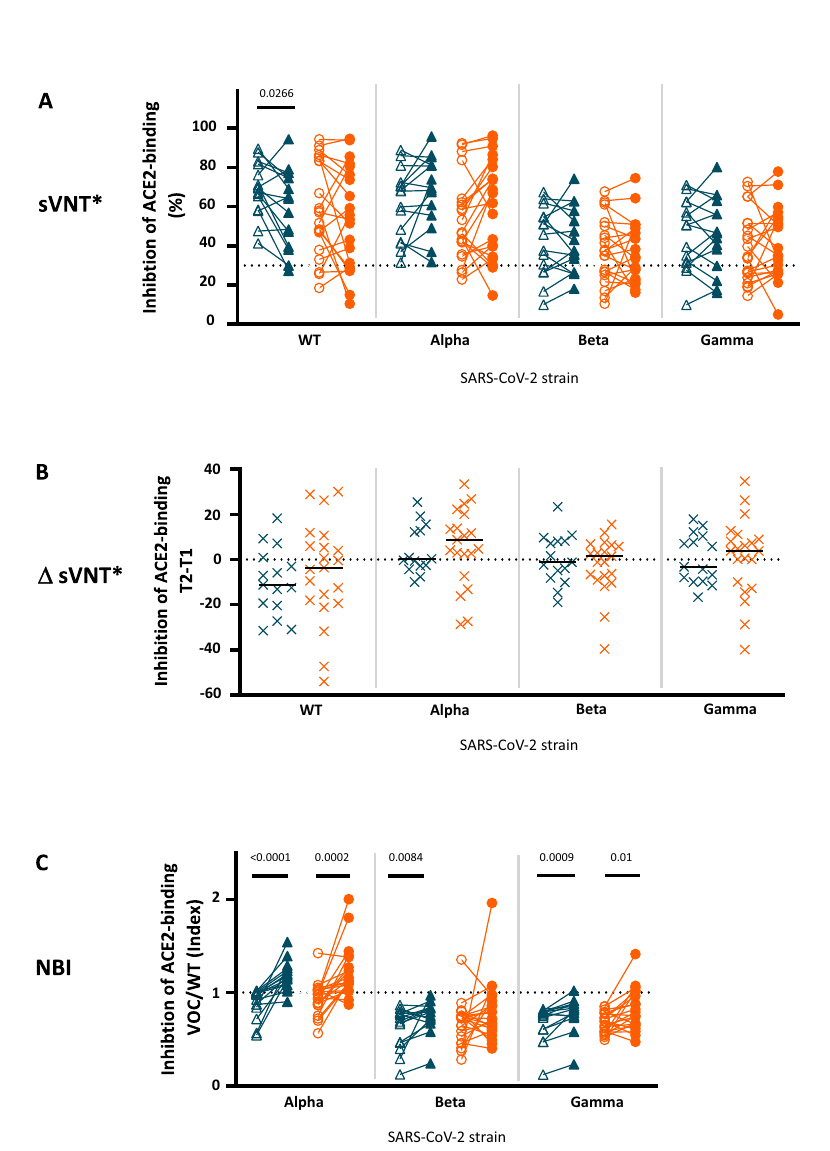
Fig. 2 | Longitudinal decrease in neutralizing capacity against the original Wuhan (WT) strain with increasing neutralization breadth in children and adults. Only participants who were seropositive at T1 (for de fi nition of ser- opositivity see Methods) and who were tested in T2 (excluding vaccinated indivi- duals) are plotted (16 adults, 21 children). A Neutralization serum capacity against parental(WT,Wuhan)andVariants of Concern(VOC):Alpha(B.1.1.7),Beta(B.1.351) and Gamma (P.1) strains was tested with the AcroNT SARS-CoV-2 Surrogate Virus NeutralizationTest(sVNT*)atT1(4monthsafterdiagnosis;emptysymbols)andT2 (12 months after diagnosis; fi lledsymbols) in adults( A ; blue symbols) and children ( C ;orangesymbols);dottedlinerepresentsacut-offvalueforneutralization(30%).